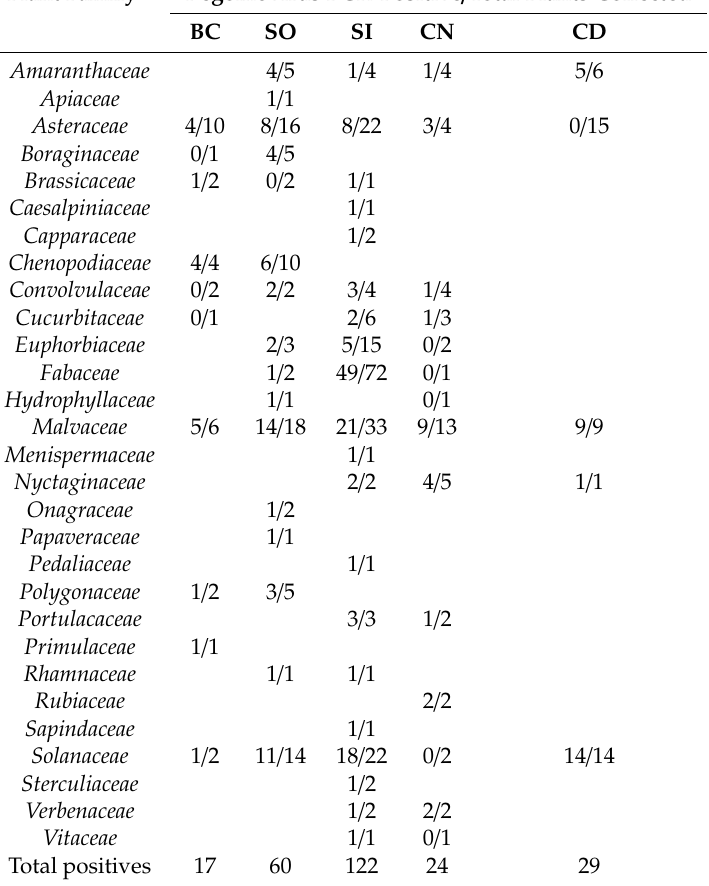
Table 1. Begomovirus detection in plants collected in the agro-ecological interface from Northern-Pacific regions of Mexico. Total DNA from each individual specimen was used as a template for PCR-mediated begomovirus